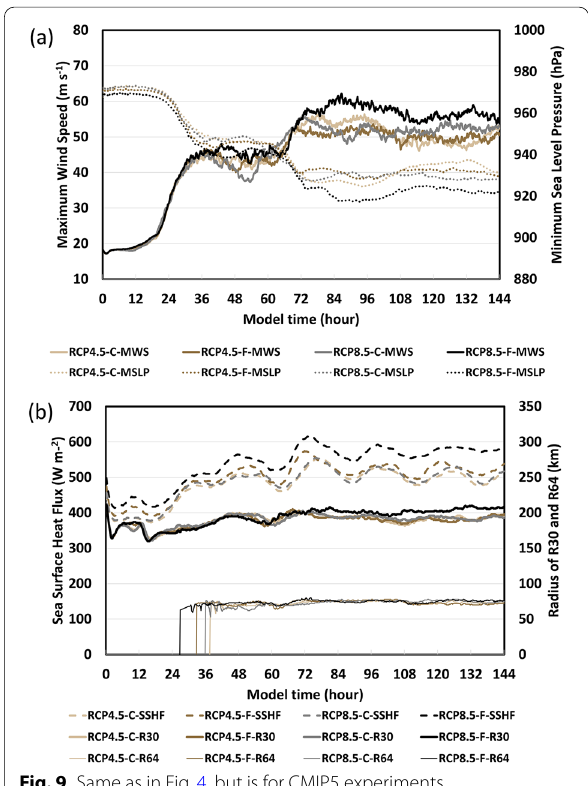
Fig. 9 Same as in Fig. 4, but is for CMIP5 experiments